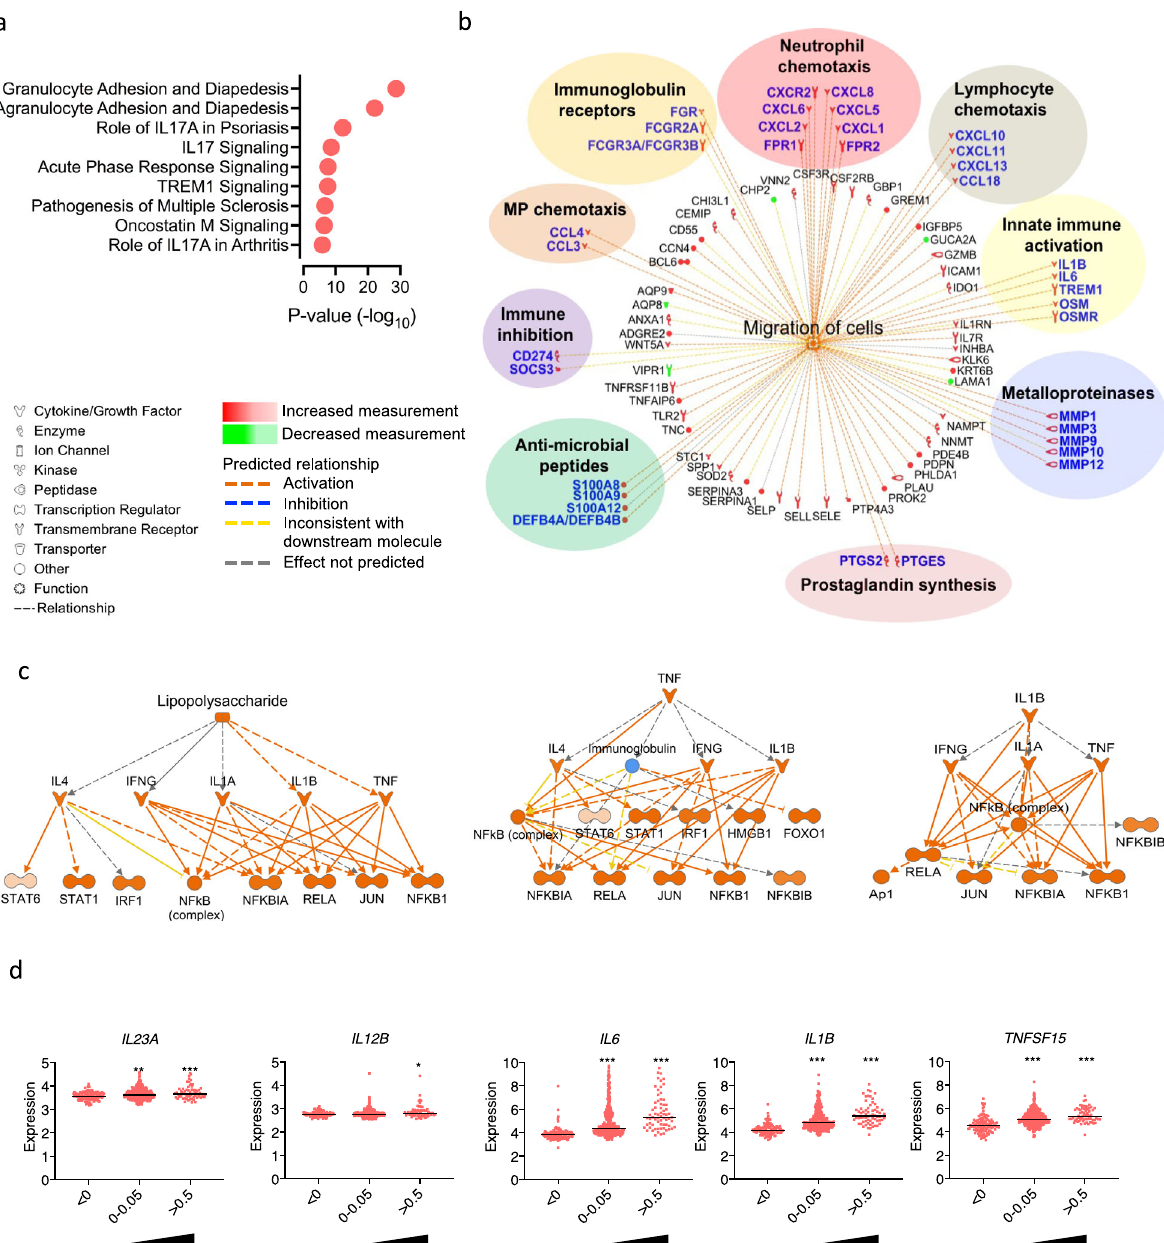
Fig. 2 | Biological pathways and upstream regulators associated with enrich- ment of the IL-22 regulated transcriptional program. a Pathway enrichment analysis(IPA)ofthedifferentiallyexpressedgenesinpatientsenrolledinUNIFIwith high enrichment for the IL-22 transcriptional program (right-tailed Fisher ’ s exact test), b genes belonging to “ Migration of cells ” pathway that are upregulated in patients with high enrichment of the IL-22 transcriptional program, as identi fi ed usingIPAdownstreamanalysis.Geneshavebeenfurthersubdividedintofunctional categories. Symbols denote type of protein, color denotes regulation and color of